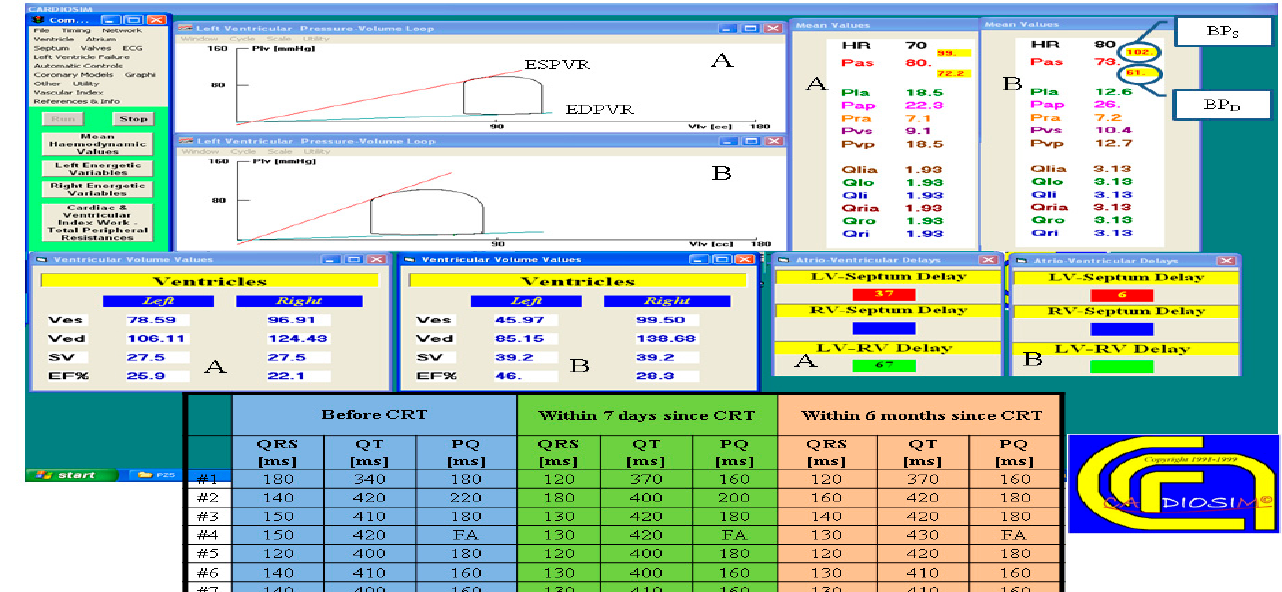
Figure 5. Screen output from CARDIOSIM © reproducing the hemodynamic conditions of patient #5, simulated from hemodynamic parameters and ECG timing measured in the clinical environment, and represented on the left and right pressure–volume planes with the end-systolic (end-diastolic) pressure–volume relationship ESPVR (EDPVR). The mean (evaluated during the cardiac cycle) systolic arterial pressure (Pas), the mean pulmonary arterial pressure (Pap) and the input flow of the left (right) atrium Qlia (Qria) are listed in the screen output. The stroke volume (SV) with the left and right end-systolic (diastolic) ventricular volume Ves (Ved) are listed in the two tables on the left. “LV-Septum Delay” is the intraventricular delay time; “LV-RV Delay” is the interventricular delay time. The lower middle table shows the ECG timing parameters (PQ, QRS and QT duration) measured in seven patients before cardiac resynchronization therapy (CRT) and seven days and six months after CRT. (Reprinted with permission from [67], Copyright © 2022–2019 C. De Lazzari.)